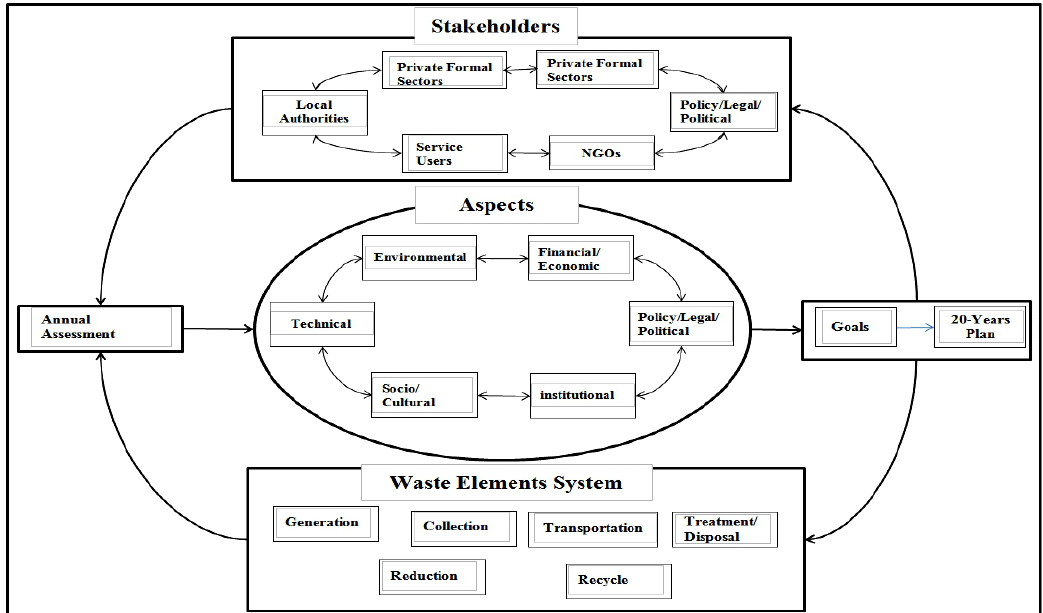
Fig. 3: Conceptual ISWM model in